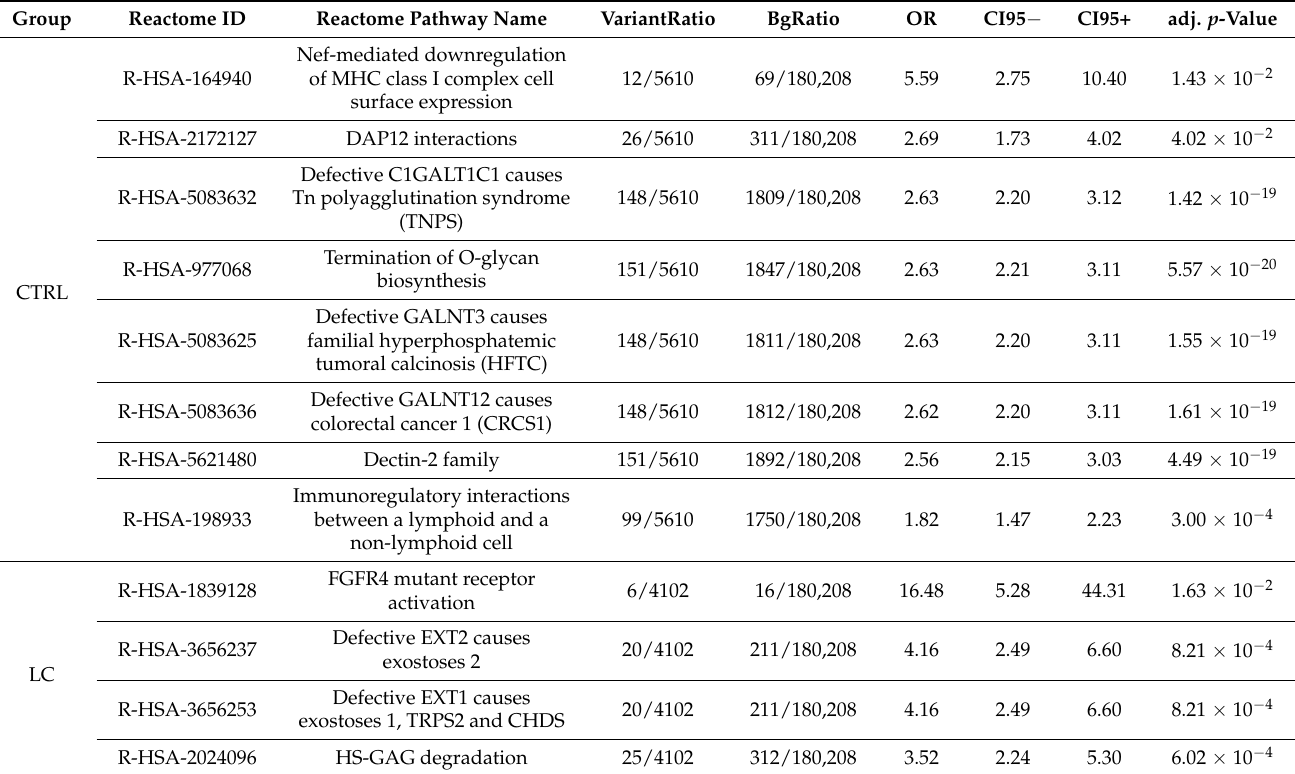
Table 2. Enriched pathways found for the control (CTRL), Lung Cancer (LC) and Malignant Pleural Mesothelioma (MPM) groups.